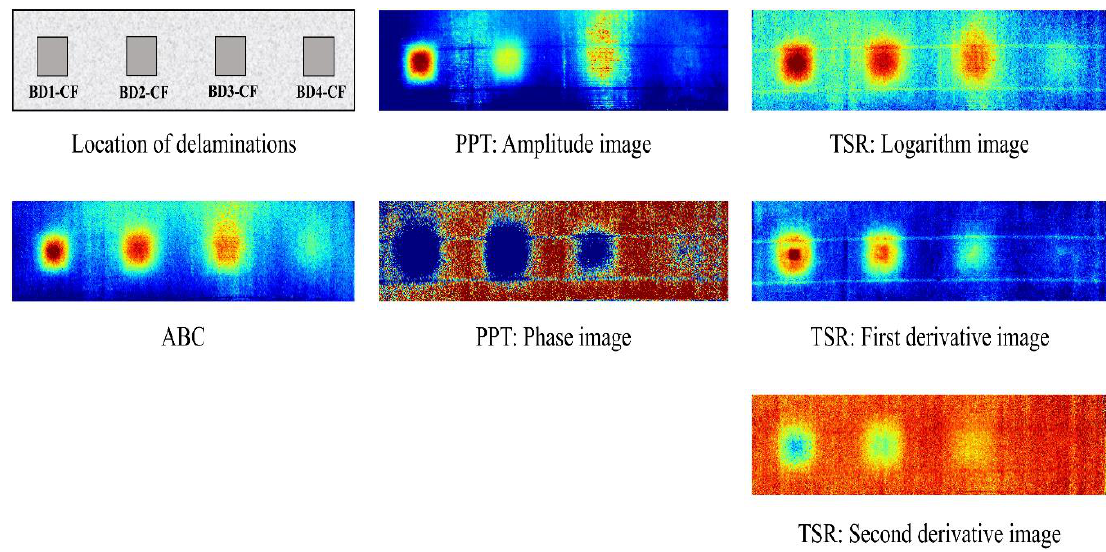
Figure 13. Thermal images using different algorithms (data used in the case of 10-min heating from back-face).